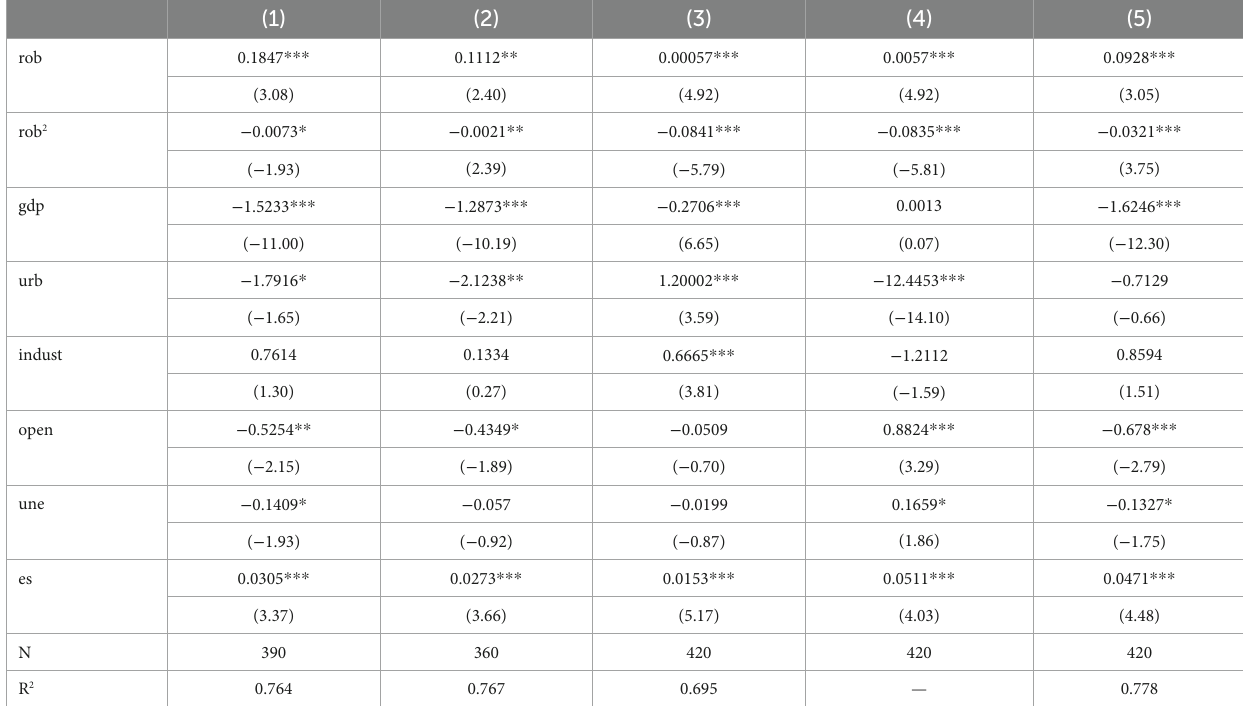
TABLE 5 Results of robustness